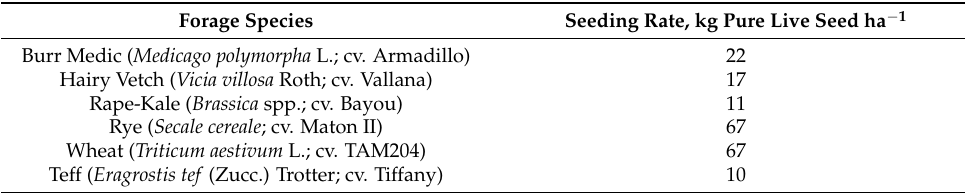
Table 2. Summary of seeding rates for all forage